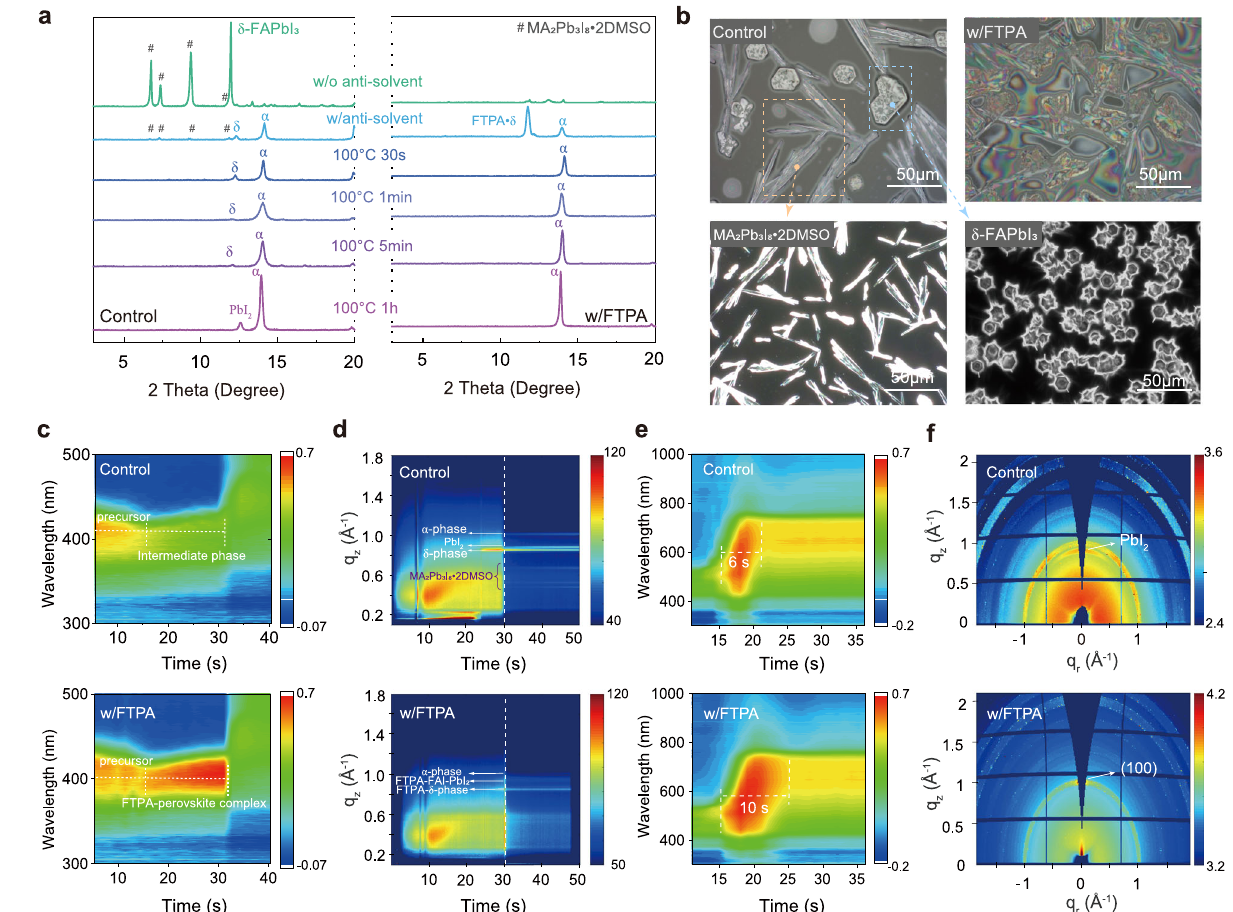
Fig. 2 | In-situ monitoring of intermediate phase, nucleation, and crystal- lization process of the control and FTPA based perovskite fi lms during spin- coating and annealing procedures. a In-situ tracking of X-ray diffraction of the perovskite fi lms during three processes: wet perovskite fi lm without (w/o) anti- solvent during spin-coating, wet perovskite fi lm with (w) anti-solvent during spin- coating,andperovskite fi lmsannealedat100°Cforvarioustimes. α and δ symbols indicated α -phaseand δ -phaseperovskite. b Opticalmicroscopyimagesofthewet